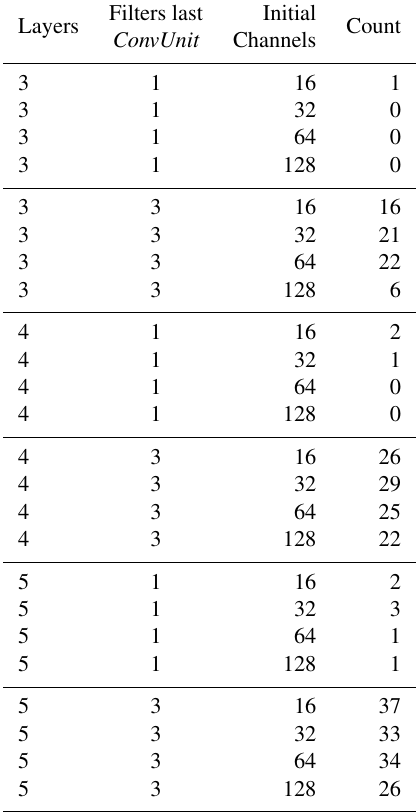
Table A2. Similar to Table 4 but grouped according to amount of layers , filters in the last ConvUnit , and initial feature channels .